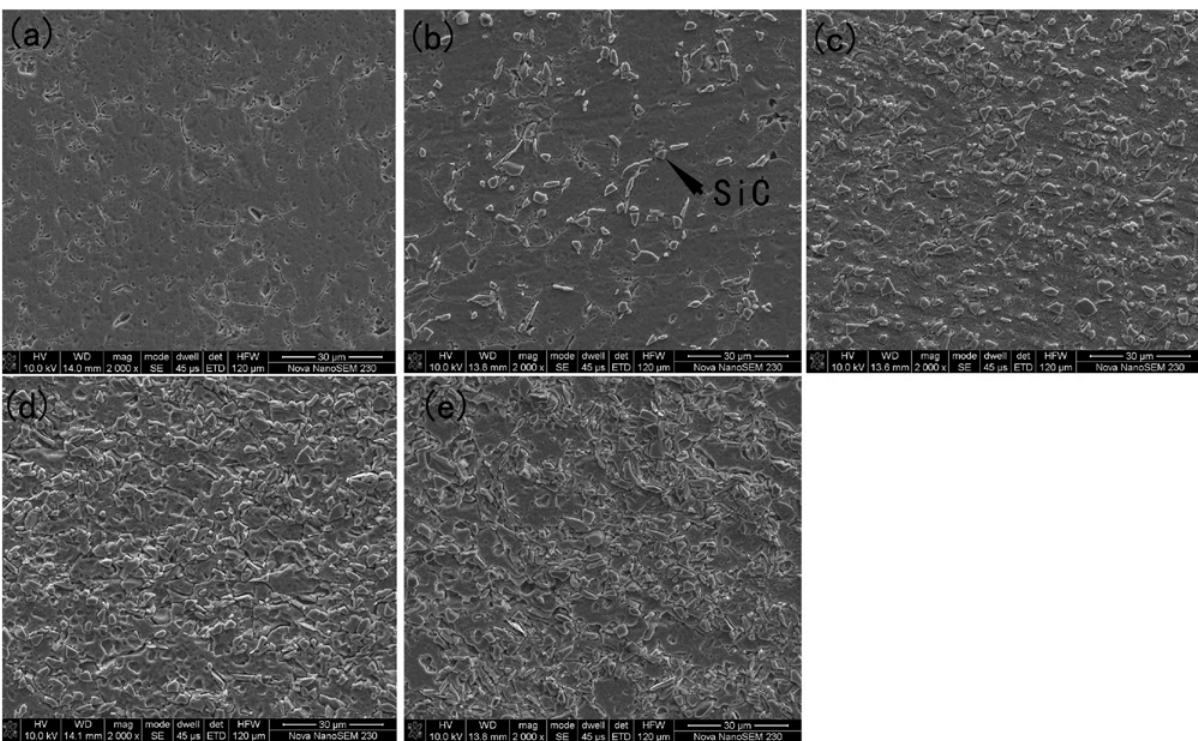
Figure 2: Microstructure graphs of the samples after hot sintering at 600 ° C. (a) Sample 1; (b) sample 2; (c) sample 3; (d) sample 4; (e) sample 5.